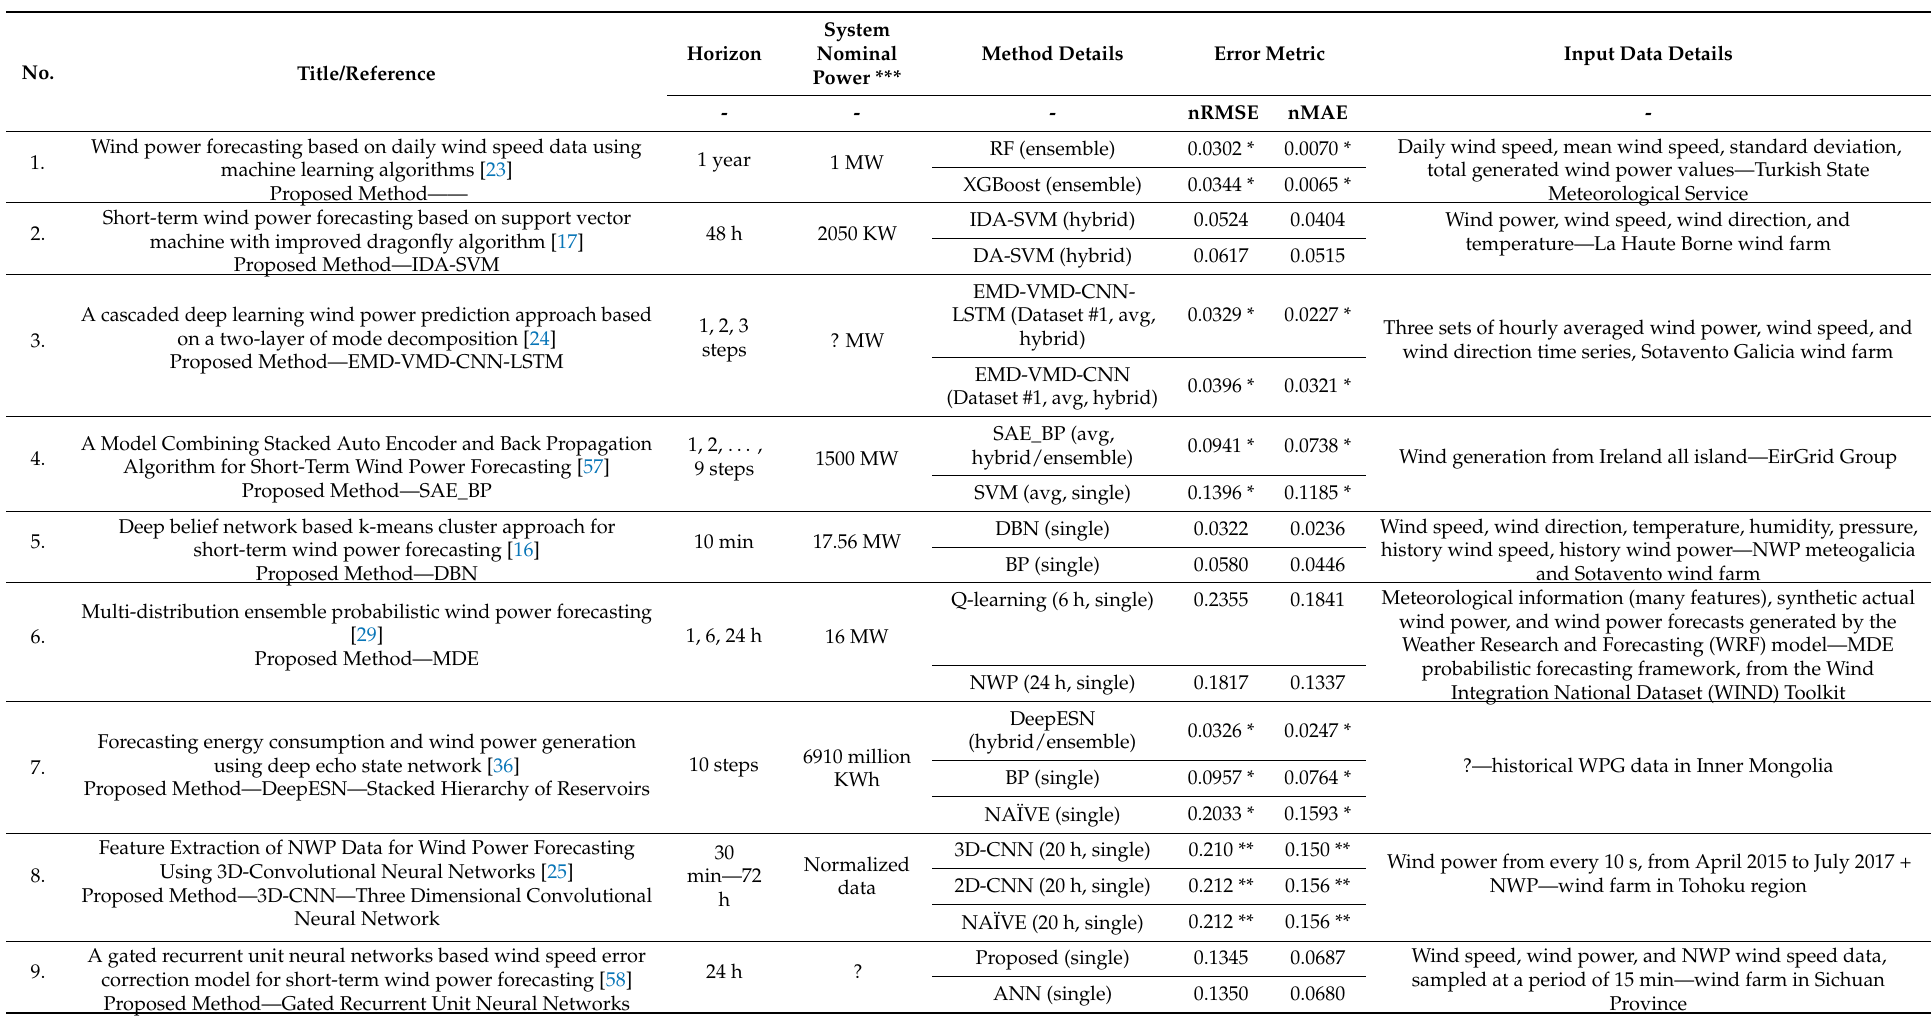
Table 5. Summary of errors obtained for onshore wind power forecasting